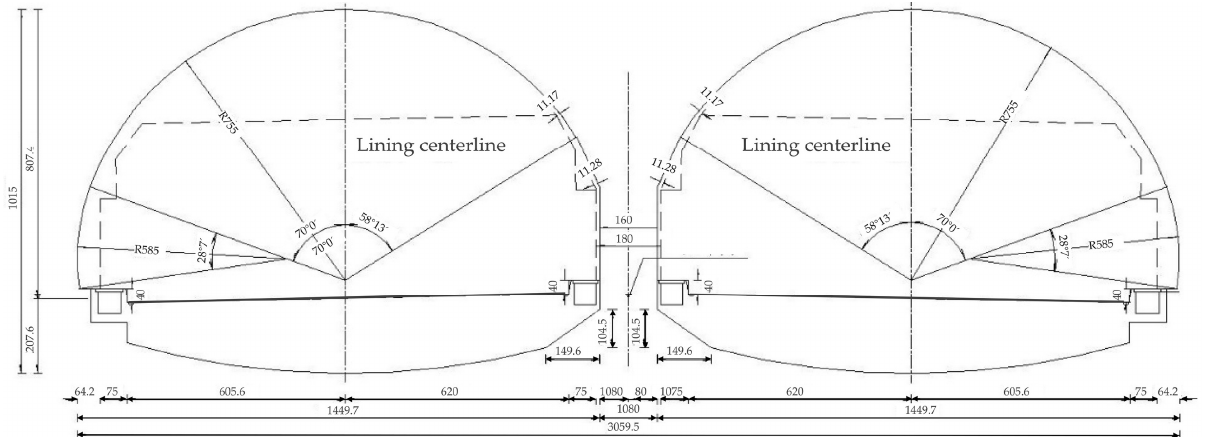
Figure 2. Cross-section of double-arch tunnel (unit: cm).